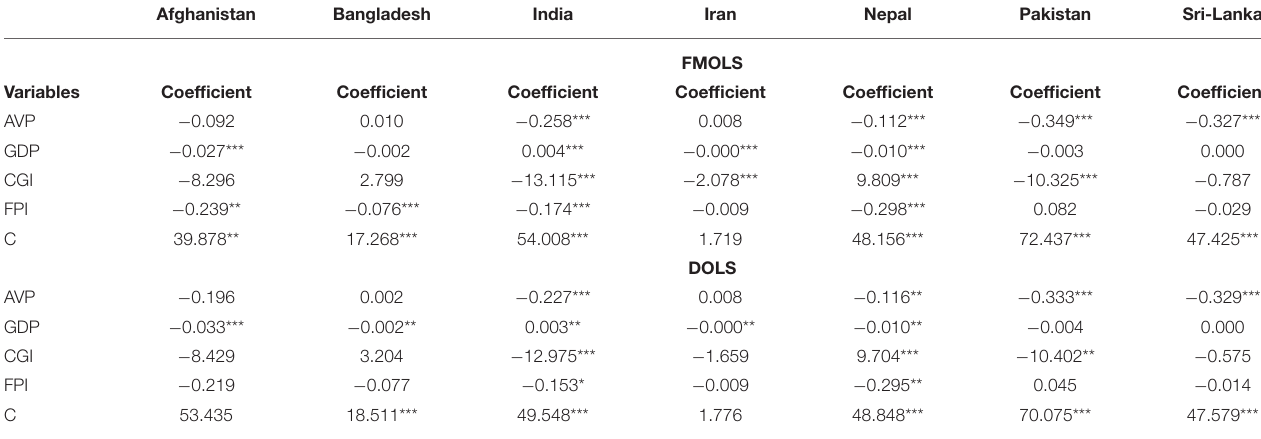
TABLE 9 | Cross country analysis of POU.